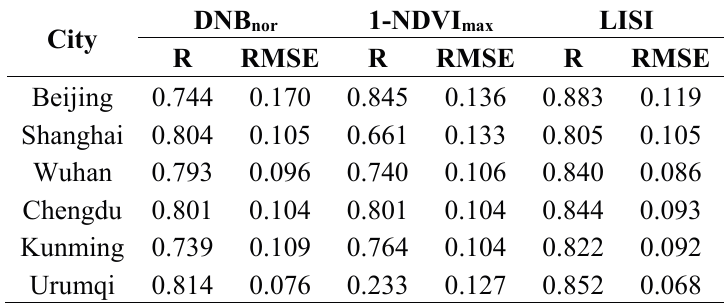
Table 5. Comparison of accuracy analysis results from three variables at different